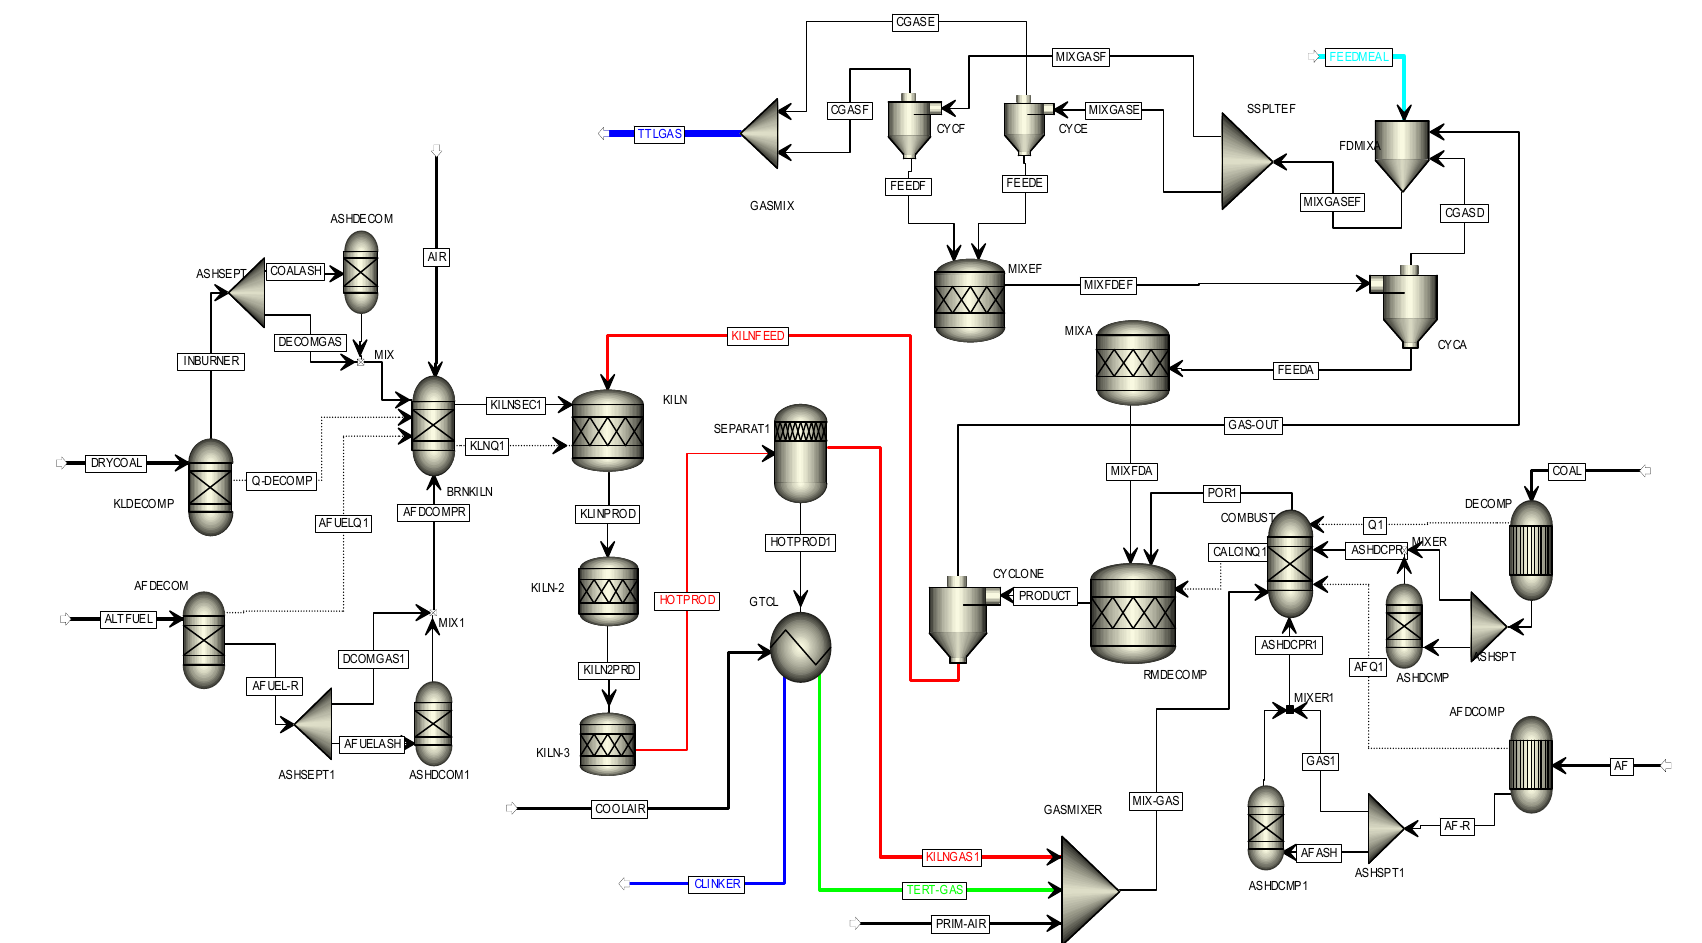
Figure 3. Aspen Plus process model flow sheet for cement manufacturing.